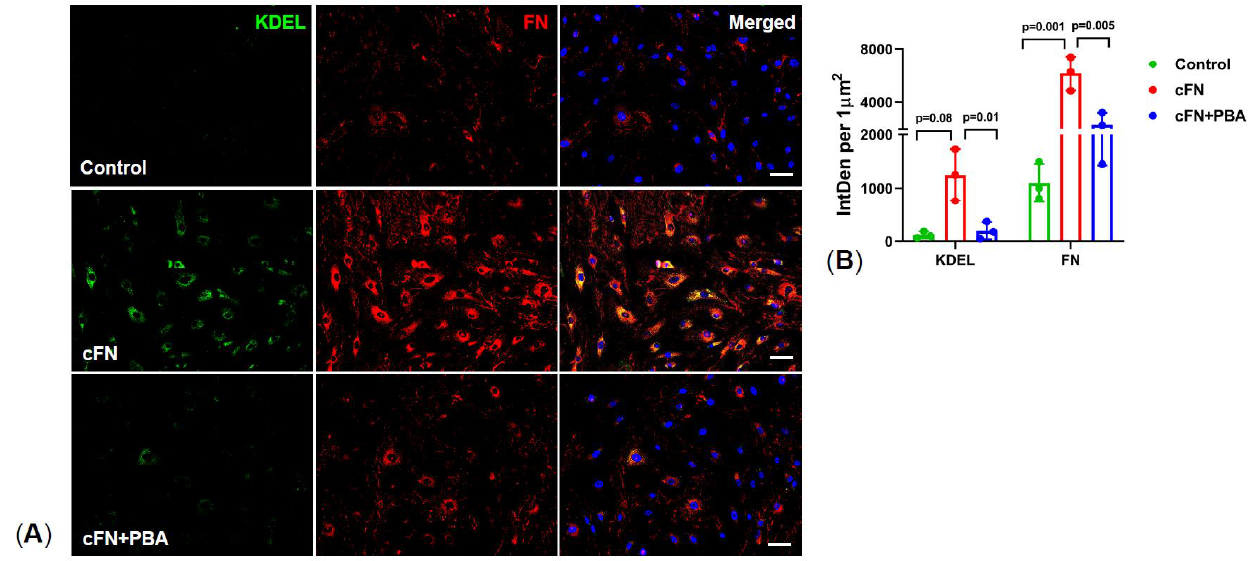
Figure 5. PBA degrades cellular fibronectin and prevents ER stress in primary human TM cells: Primary human TM cells were grown to 80% confluency on 4-well glass chamber slides, treated with either cFN (10 μg/mL) or cFN + PBA for 5 d, and immunostained for FN and KDEL (ER stress). Representative images ( A ) and analysis ( B ) confirmed that PBA degraded cFN and also prevented ER stress associated with cFN in primary human TM cells. ( n = 3 strains, scale bar 50 µm, ONE WAY ANOVA with multiple comparison).